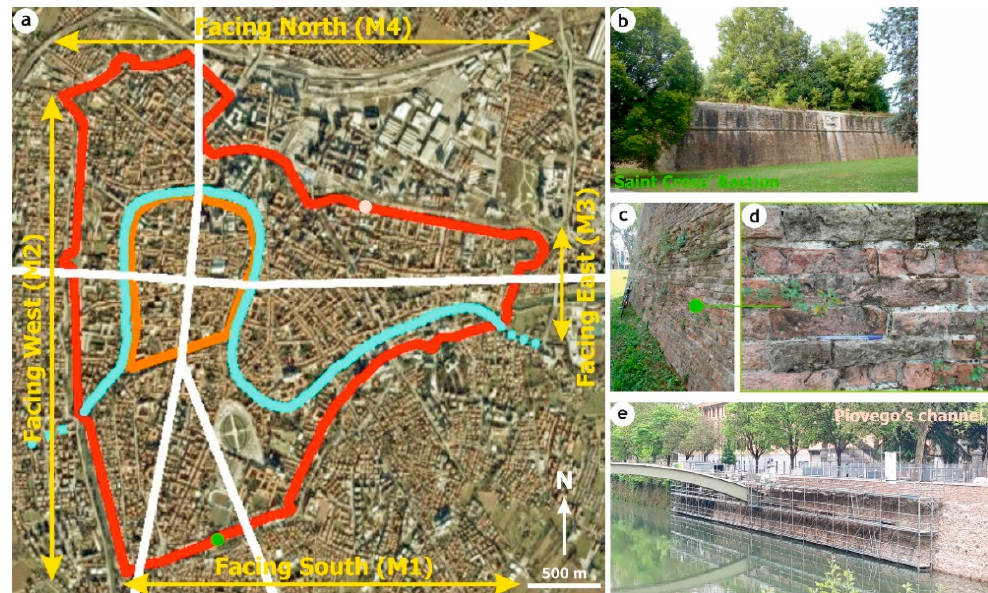
Figure 2. Padua’s Renaissance walls. ( a ) The irregular perimeter of the Renaissance walls (red) in- cluded the Medieval walls (orange)—today largely disappeared—and the fluvial system that crossed the city (light blue)—nowadays somewhat changed-. The white lines are the main passageways that articulated the Medieval city according to the corresponding Medieval gates; ( b – d ) brick fabrics on the facing South in 2019; ( e ) intervention on the wall accomplished during 2020–2021.